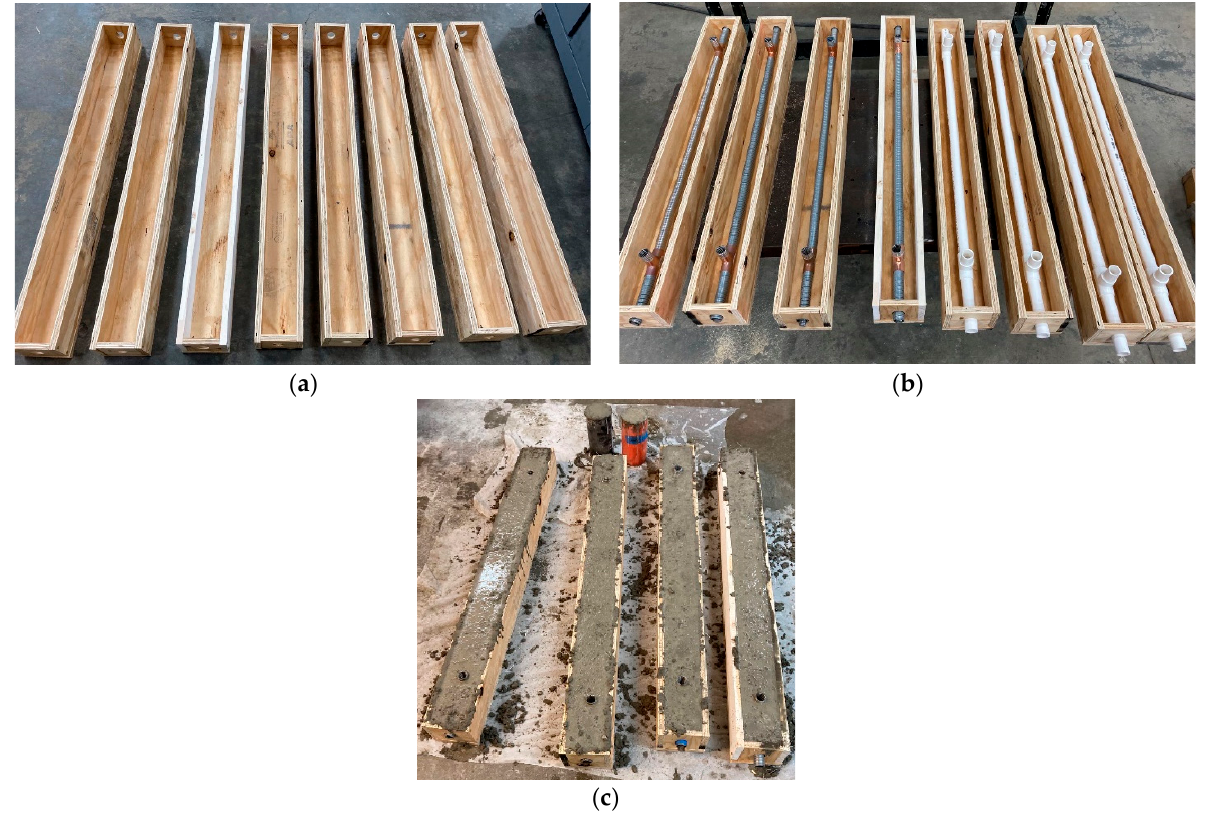
Figure 2. Specimen fabrication: ( a ) mold assembly; ( b ) plastic pipe and corrugated steel duct for post-tensioning strand and grouting; and ( c ) casting specimens. Table 3. Specimen design with different parameters. Table 3. Specimen design with different